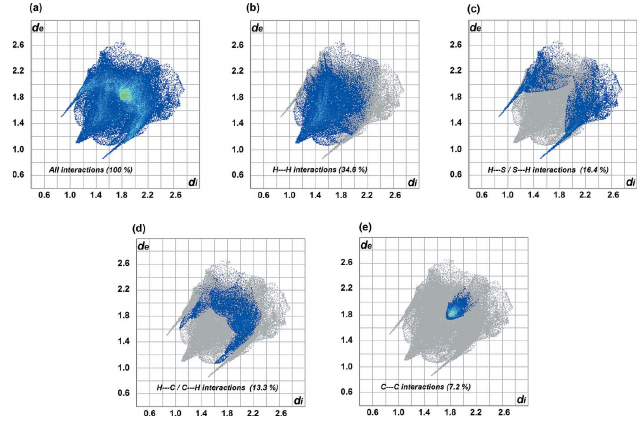
Figure 7 The fingerprint plots for ( 1 ).